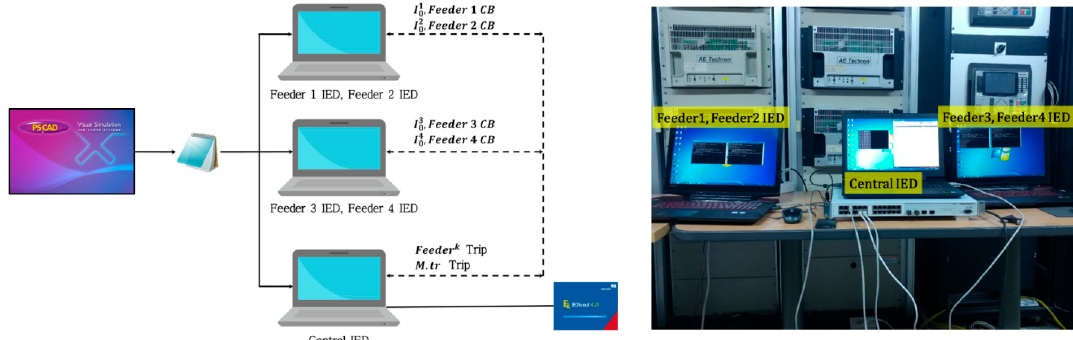
Figure 10. The test environment for the centralized protection scheme.